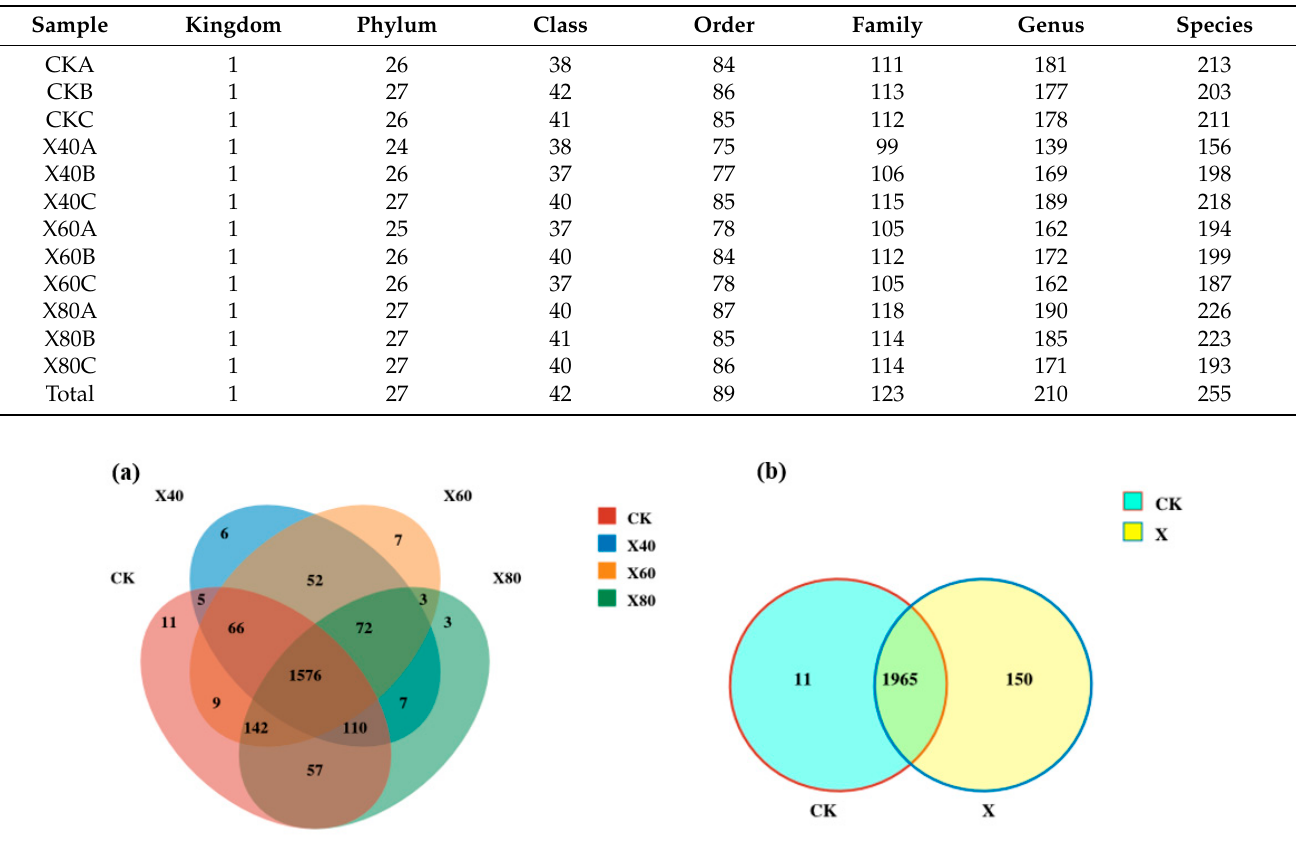
Figure 5. Venn diagram of samples from the four treatments ( a ) and Venn diagram of samples from root-restriction and CK treatment ( b ). In the root-restriction group, there were three cultivation patterns, with widths of 40, 60, and 80 cm (X40, X60, X80, respectively,) for root restriction; CK was conventional cultivation with no root restriction.